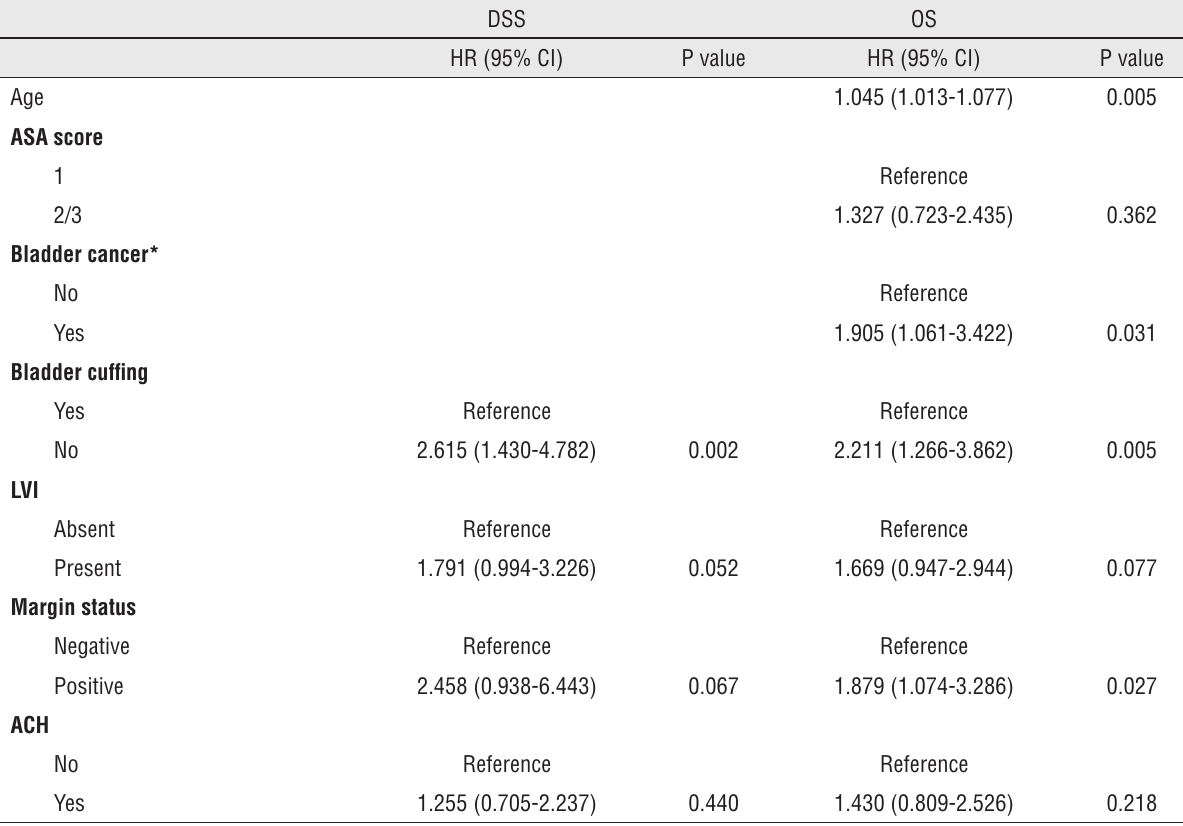
Table 2 - Multivariate Cox proportional hazards regression analysis of disease-specific survival and overall